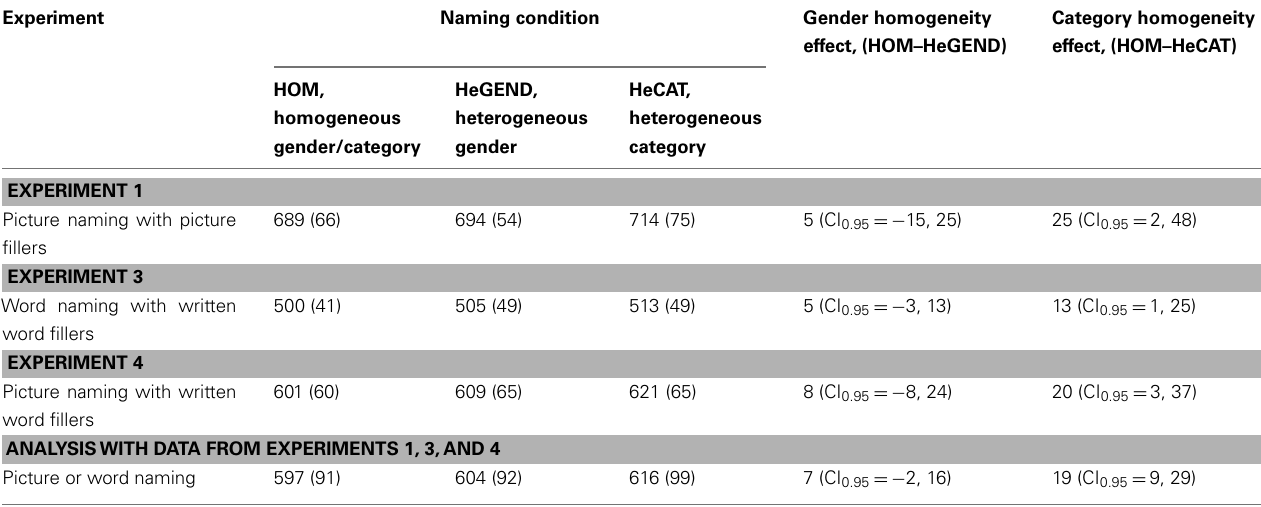
Table 1 | Results of Experiments 1, 3, and